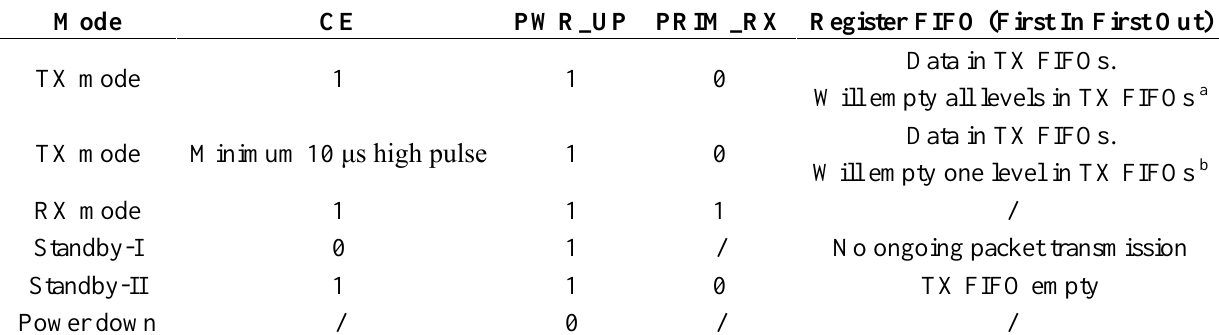
Table 6. Operation modes configuration